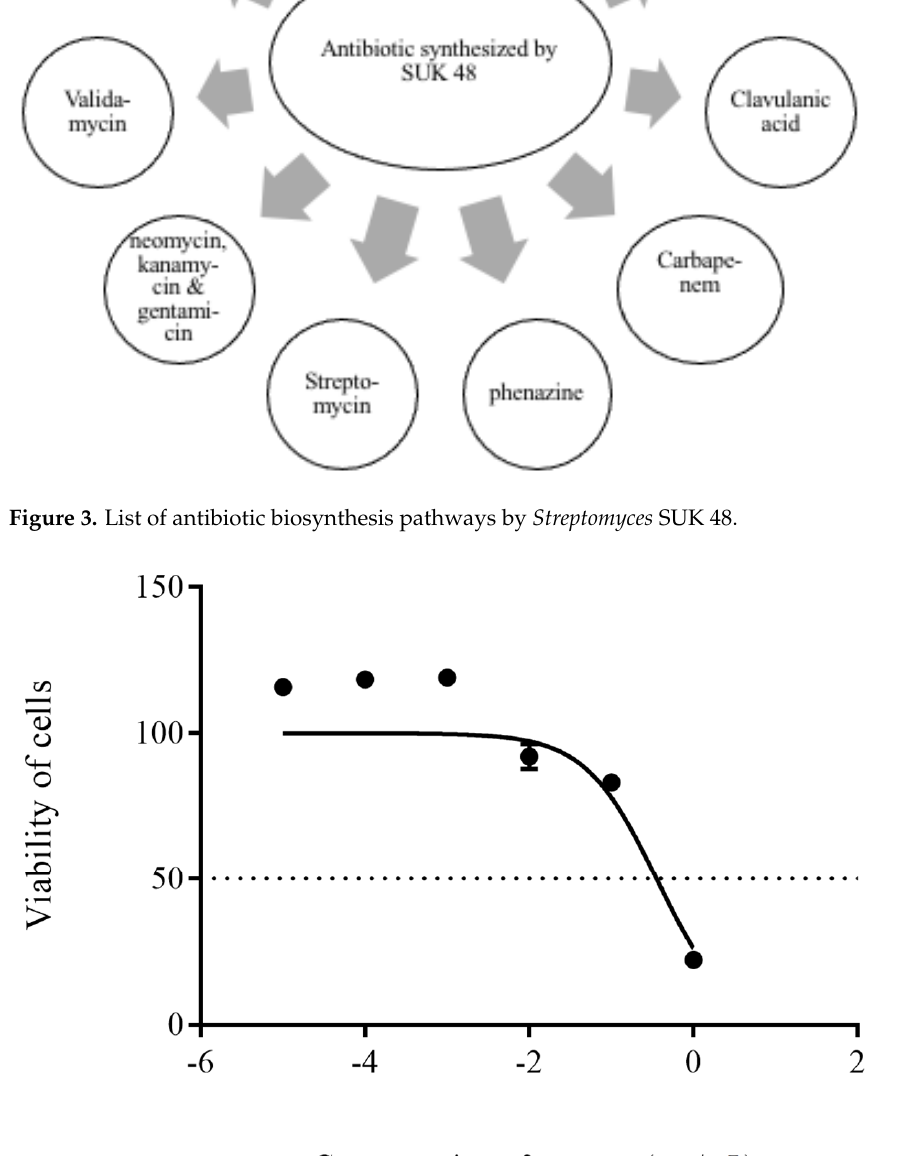
Figure 3. List of antibiotic biosynthesis pathways by Streptomyces SUK 48.